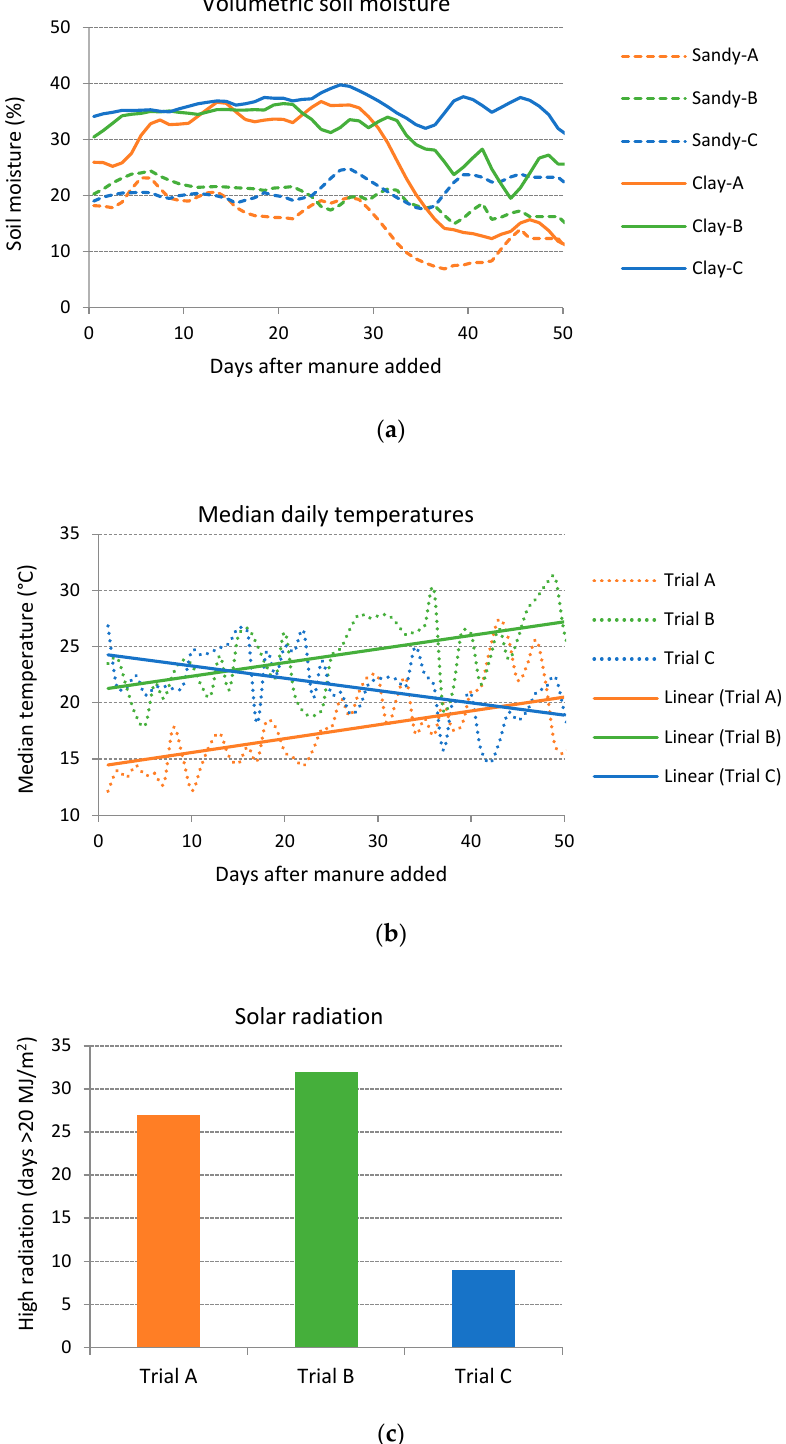
Figure 1. ( a ) Average soil moisture in sandy (dashed lines) and clay loam (solid lines) soils for trials A, B and C. Values are running means from 24 h data. ( b ) Median daily temperatures, with linear trend lines plotted. ( c ) Total days during each trial with >20 MJ/m 2 solar